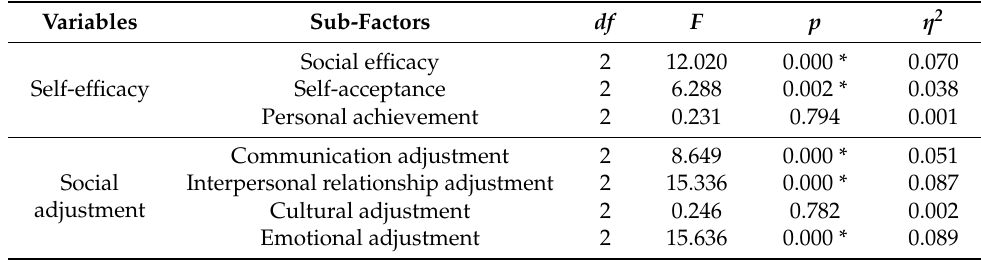
Table 4. Results of the MANOVA.